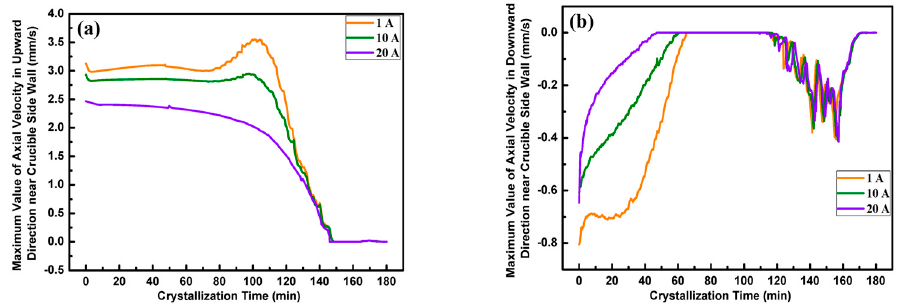
Figure 8. The maximum value of the flow velocity of the silicon melt in the vertical direction near the sidewall of the crucible in the crystallization stage: ( a ) the direction is upward; ( b ) the direction is downward.